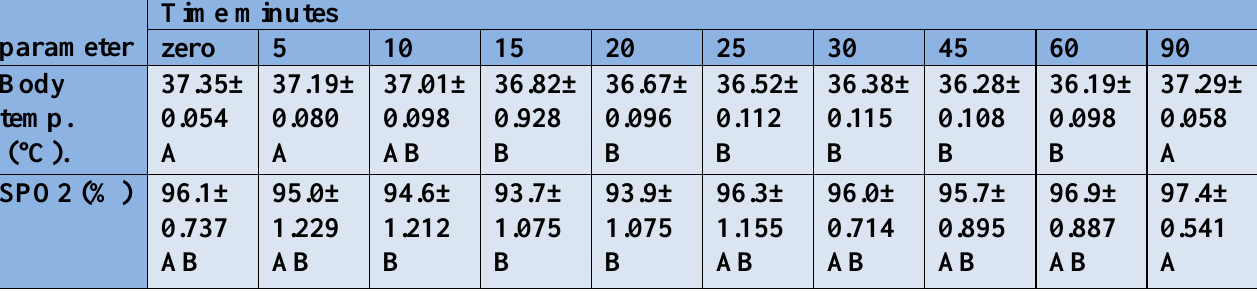
Table 2: Effect of general anesthesia regime on some clinical parameters in (10)